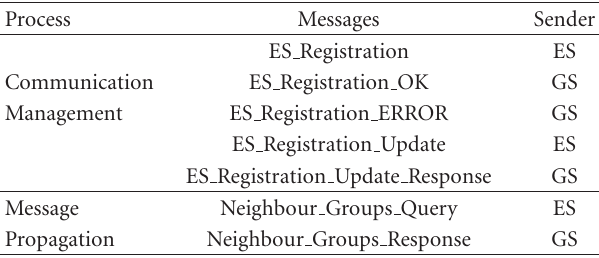
Table 2: Environment Server-Group Server communication.